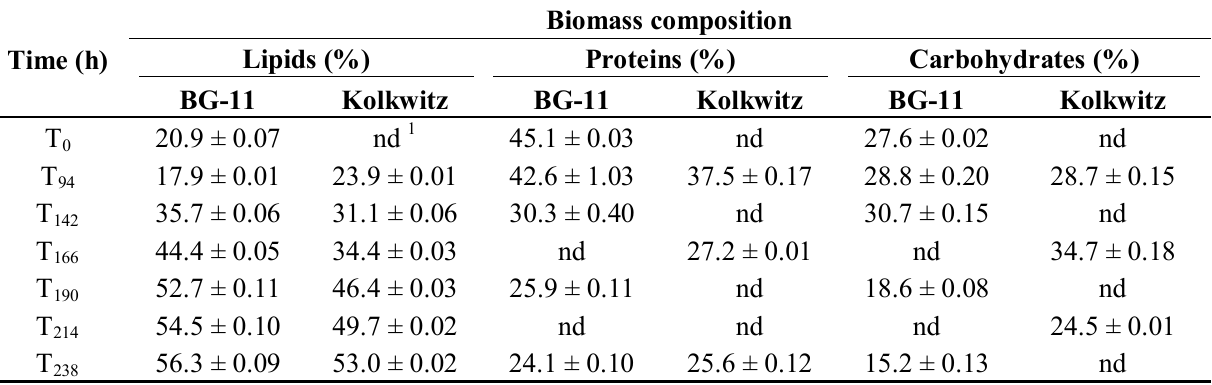
Table 3. Changes of Chlorella vulgaris CCALA 896 biomass composition versus time, in both modified BG-11 and Kolkwitz culture broths, during a nutrient sufficient phase (T –T ) followed by a N and P deprived phase (T 0 94